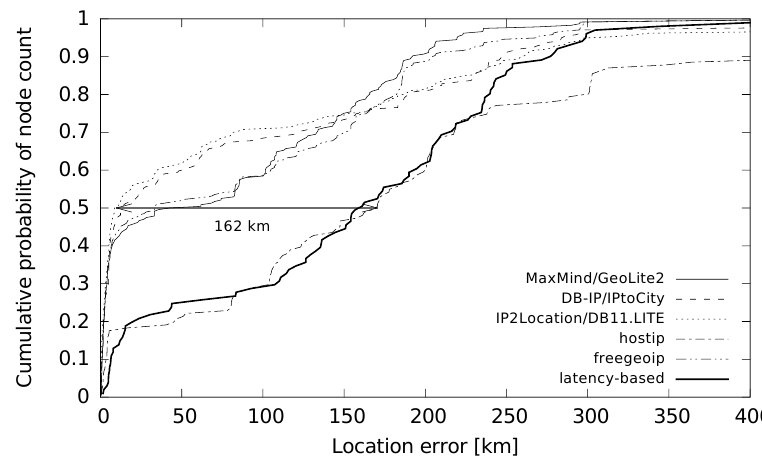
Figure 9. Location accuracy—distance errors for large cities with population p > 17,000.